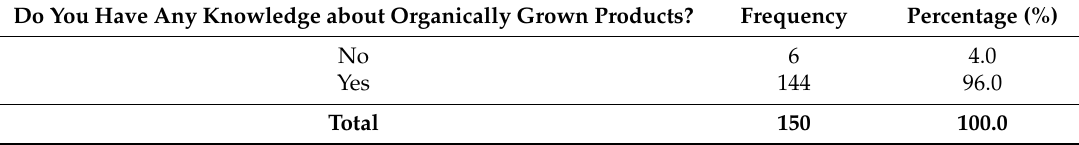
Table 3. Knowledge by Consumers of Shelly Centre about organically grown products (n = 150). Do You Have Any Knowledge about Organically Grown Products?